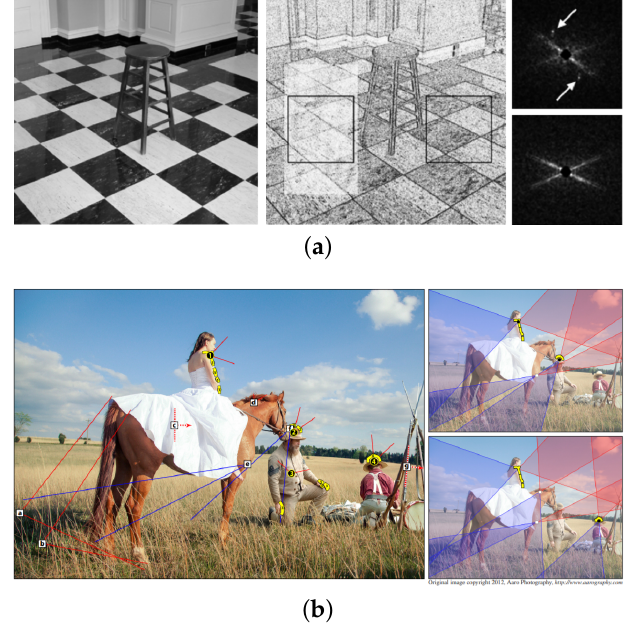
Figure 2. ( a ) The low-level image features do not rely on the image contents that make them more consistent [21]. ( b ) The high-level feature provides reasonably robust clues for the forgery detection system against general image processing such as JPEG and scaling. One example is an image forgery detection based on shading and shadows